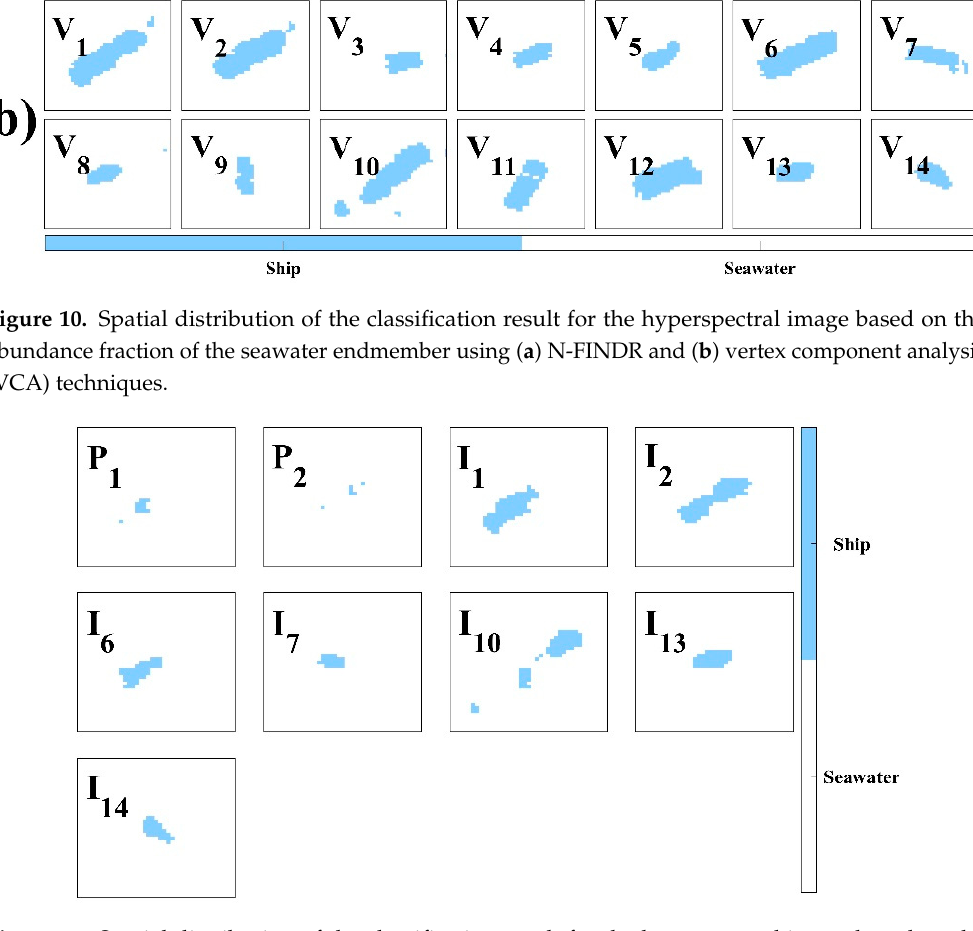
Figure 11. Spatial distribution of the classification result for the hyperspectral image based on the abundance fraction of the seawater endmember using pixel purity index (PPI) and independent component analysis (ICA) techniques.